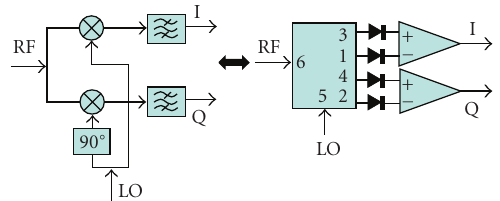
Figure 2: The equivalence between conventional I/Q mixer—the multiport